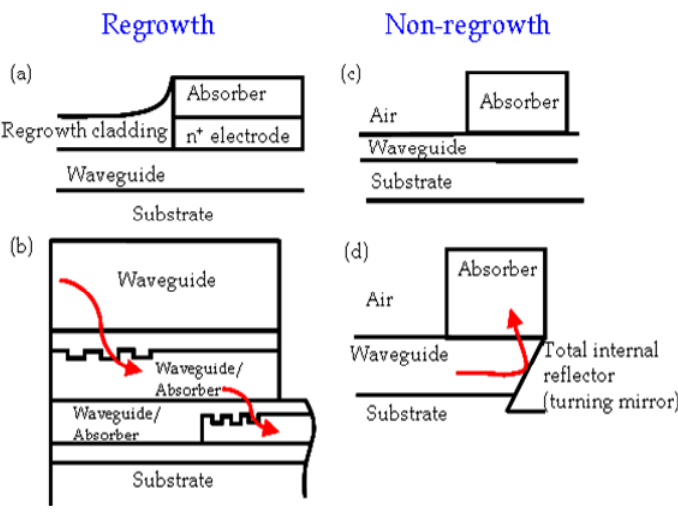
Figure 2. Methods for photodetectors integrated with optical waveguides for interconnection applications (a) butt coupling (b) grating assisted directional coupler (c) evanescent-wave/travelling-wave coupling (d) reflective